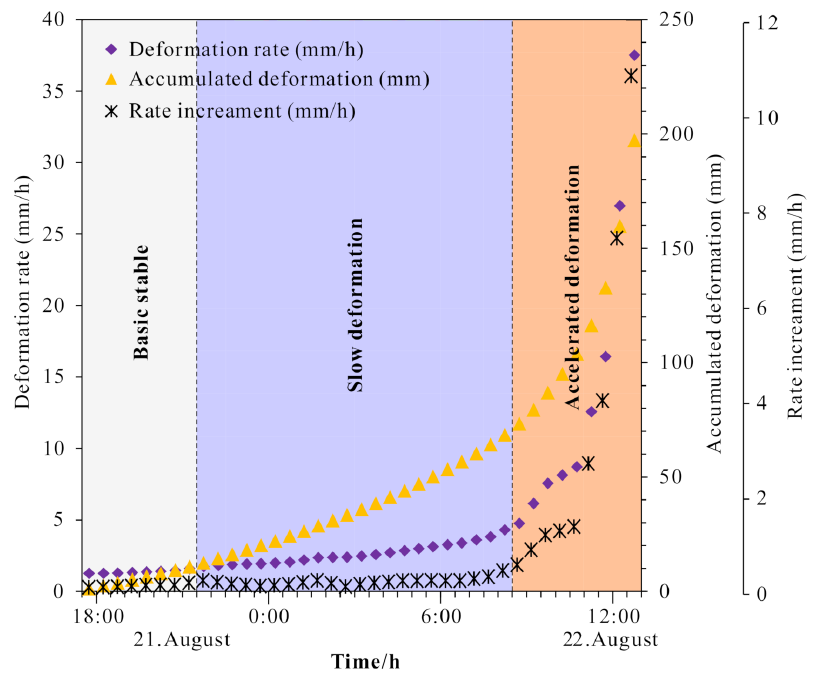
Figure 13. The detailed process of early warning in the ZHC landslide by displacement monitoring at area 1 by the MDSR-LSAR from 17:45, 21 August to 13:19, 22 August. Monitoring data showed that within the range of the landslide, the deformation was mainly located in the rear of the source area. It is suggested that the